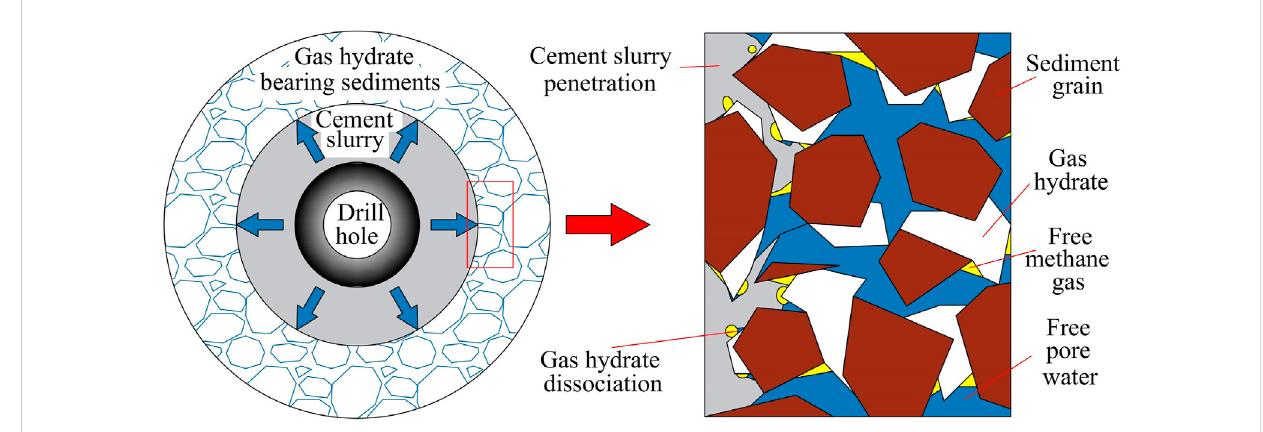
FIGURE 3 Schematic diagram of cement slurry for cementing penetrating into GHBS.